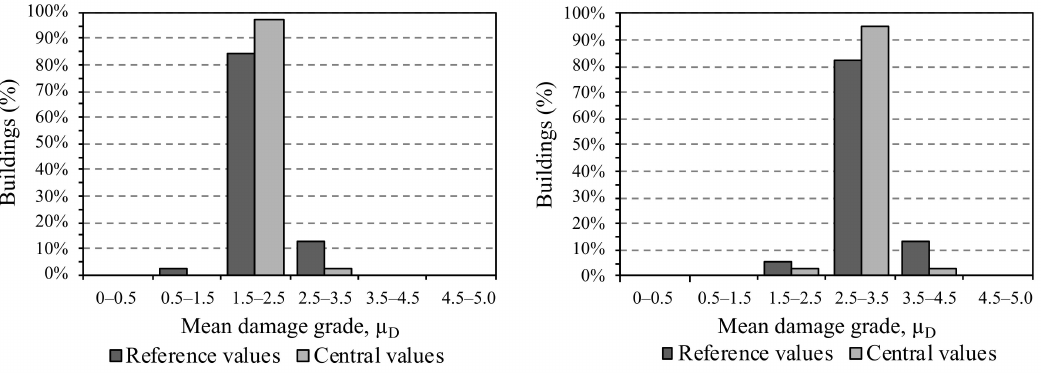
Figure 12. Mean damage grade distributions obtained from both approaches for I EMS-98 = VII ( left ) and I EMS-98 = VIII ( right ).